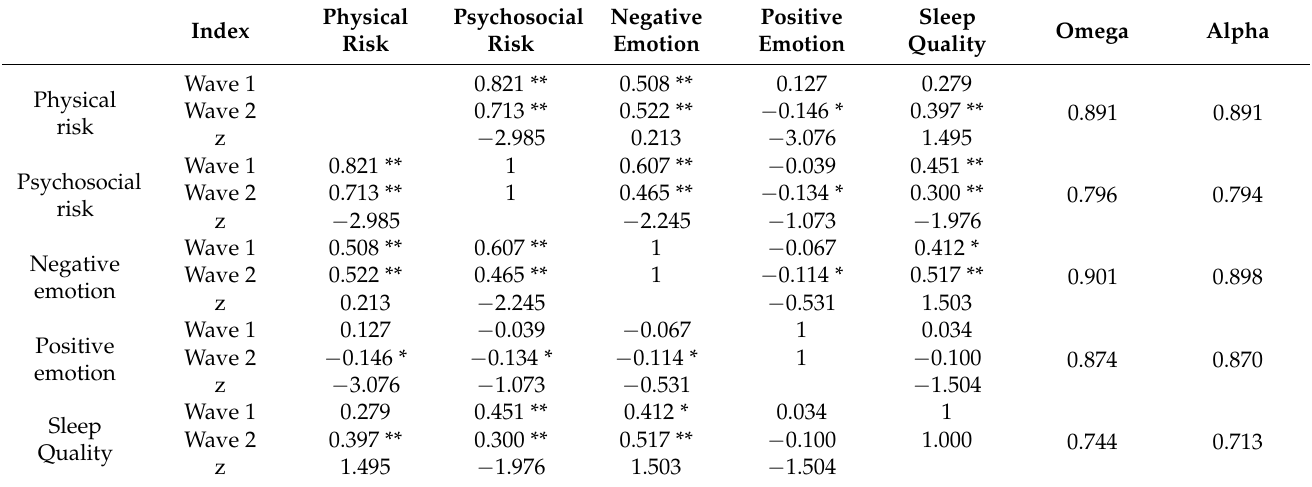
Table 4. Correlation coefficients and reliability of RPQ, PANAS, and SQS across two periods.